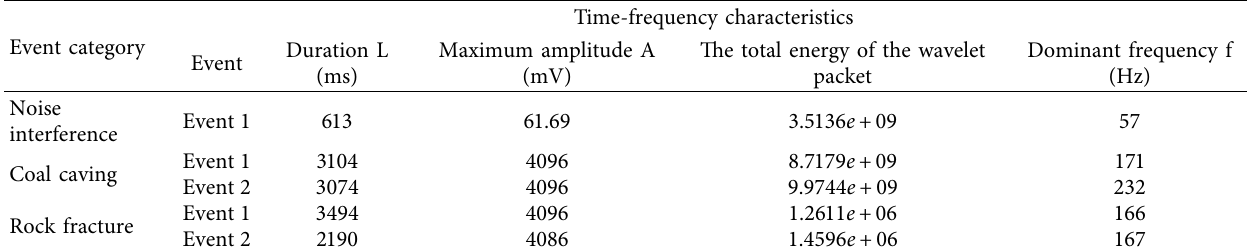
Table 4: Time-frequency characteristics of different microseismic